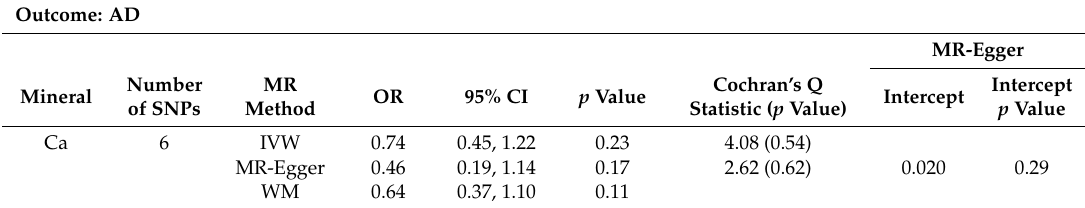
Table 7. MR estimates of the causality between five minerals and five neurologic diseases. Outcome: